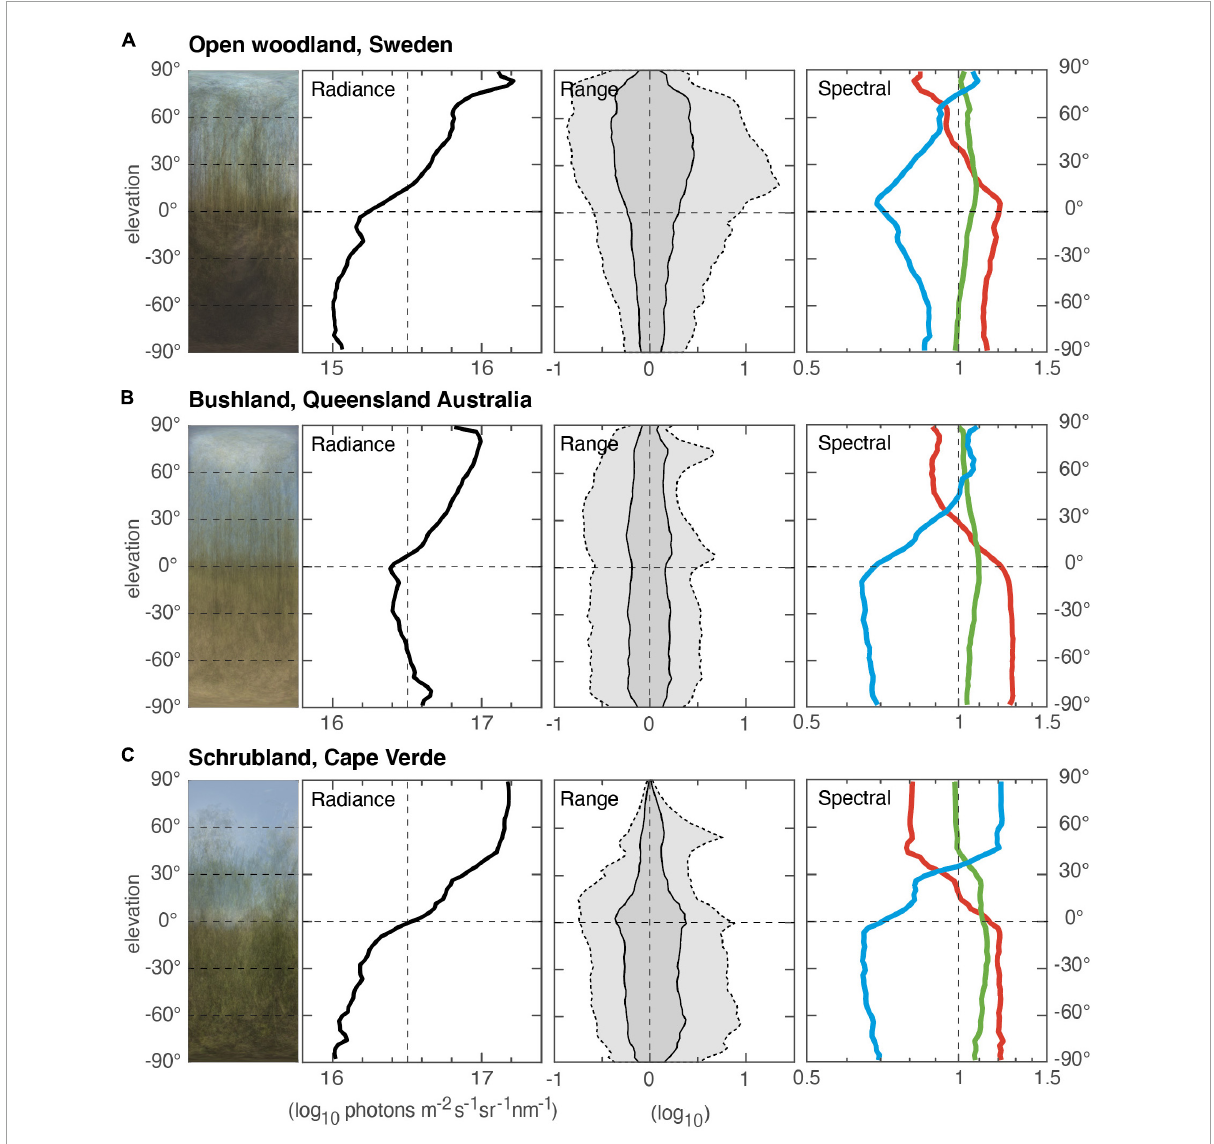
FIGURE2 Three different semi-open environments. (A) Open woodland, close to Kivik, southern Sweden (measurement based on 20 scenes, 29 March 2020, start 15:12, duration 5 min). (B) Dry bushland at Mt. Garnet, Queensland, Australia (measurement based on 26 scenes, 3 December 2012, start 10:03, duration 14 min). Here, eucalypt trees are separated by dry grass. (C) Shrubland at Serra Malagueta National Park, Santiago, Cape Verde (measurement based on 14 scenes, 6 December 2016, start 15:08, duration 6 min). In this lush mountainous terrain, low trees are mixed with bushes. All environments, (A–C) , were measured on clear, sunny days when the sun was at least 45 ◦ above the